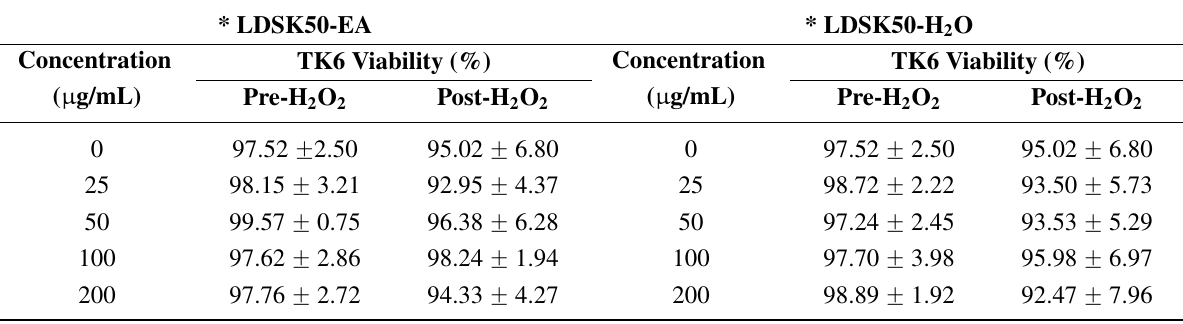
Table 4. Percentage of living cells of pre- and post-H treatments of TK6 cells with LDSK50-EA and LDSK50-H exclusion method.